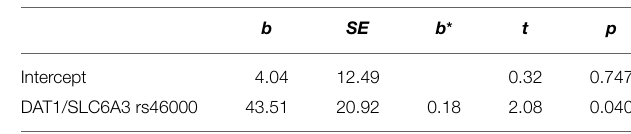
TABLE 3 | Regression of exercise-induced switch cost gain ( N = 131 ), b = unstandardized regression coefficient, SE = standard error, b * = standardized regression coefficient.